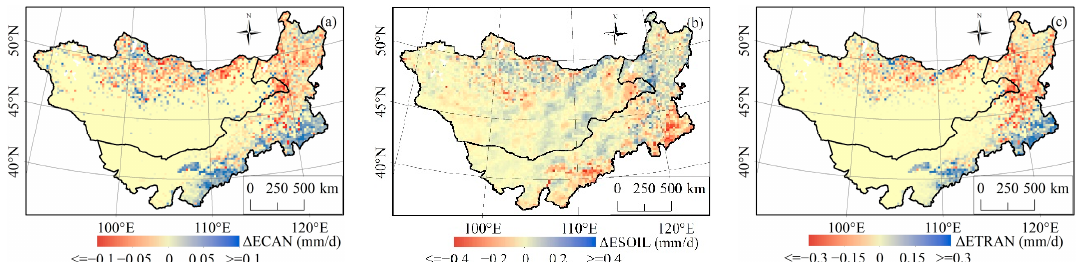
Figure 6. Model-simulated differences in ECAN ( a ), ESOIL ( b ), and ETRAN ( c ) due to vegetation changes in the growing season between scenarios of SL1990s and SL2010s.